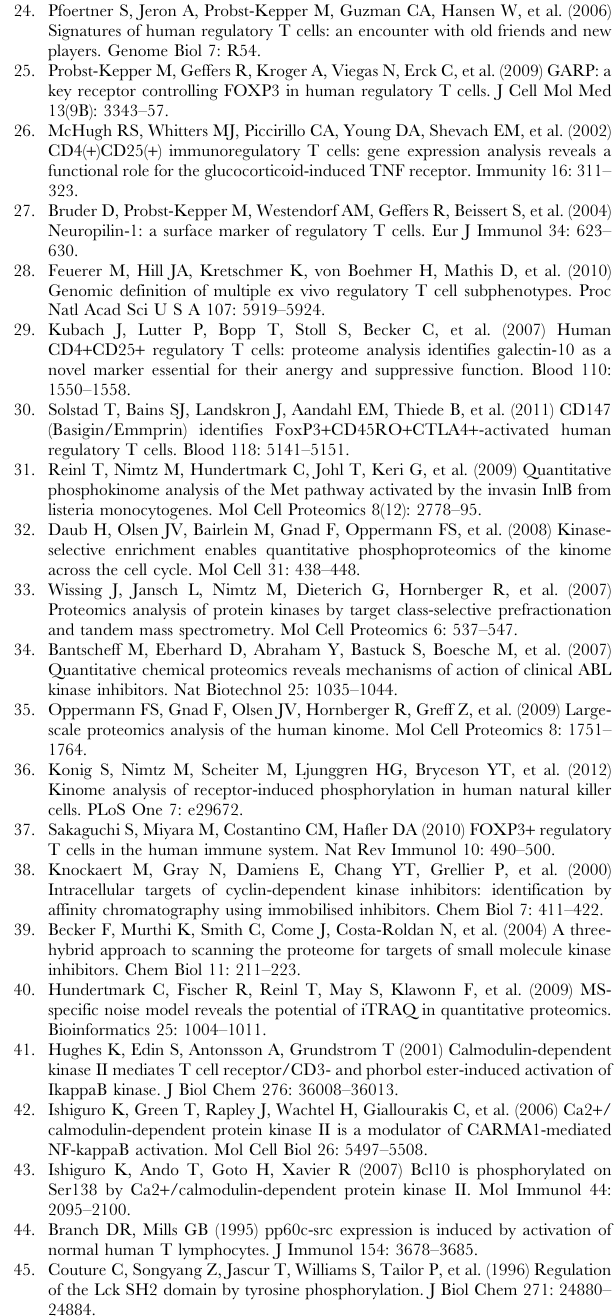
Table S1 The kinase complement of human Tregs and Teffs. Kinases, which were identified in four independently performed LC-MS/MS experiments, are listed in alphabetic order by their UniProt names. 1 UniProt name, 2 Kinase family according to Manning et al. [22], 3 Median Mascot Mowse score, 4 Frequency of identification, 5 Frequency of regulation (RF =Treg/Teff; and – is reflecting the number of experiments where the particular kinase showed a differential expression) and 6 Median regulation over all conducted